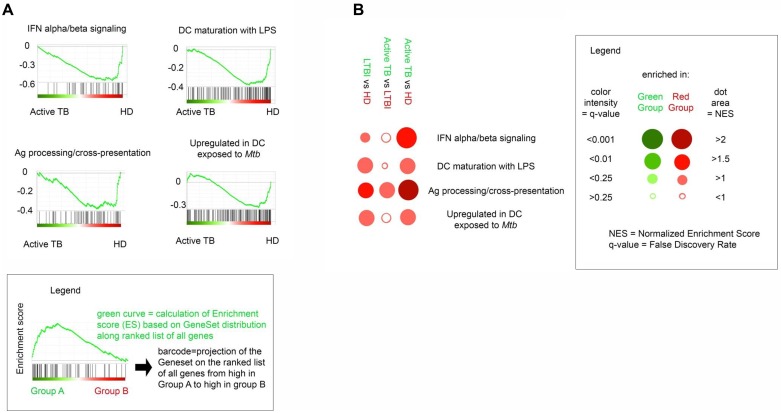
IFN-DCs derived from active TB patients are impaired for DC-related response gene signatures.A, GSEA results for comparison between active TB and HD. GeneSets relevant to DC biology are shown. Plot of the running sum for enrichment score (ES) in selected data set, the normalized enrichment score (NES) and location of genes (hits) in the list ranked according to expression differences (barcode) are shown as explained in the legend. B, Dot plot representation of GeneSet expression level in comparisons among active TB, LTBI and HD groups, as expressed by NES and q-value. As detailed in the legend, dot area is proportional to NES (<1 = no enrichment; >2 = maximum expression); dot color intensity is proportional to q-value significance, dot color indicates the group in which the GeneSet is overexpressed.